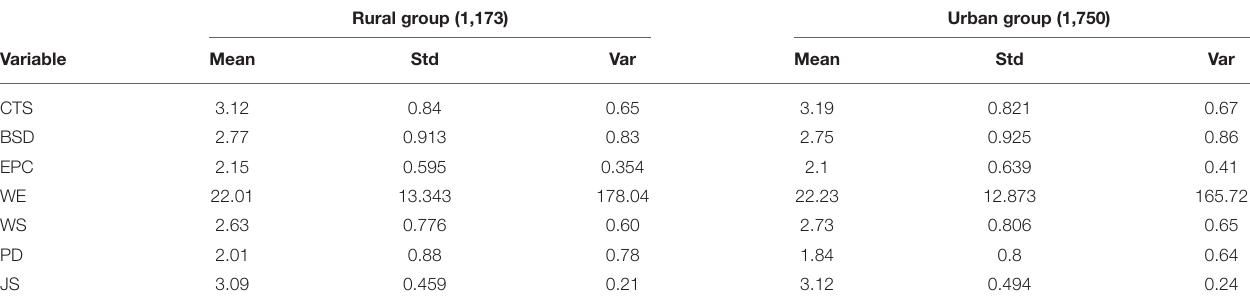
TABLE 3 | Correlation of each variable.